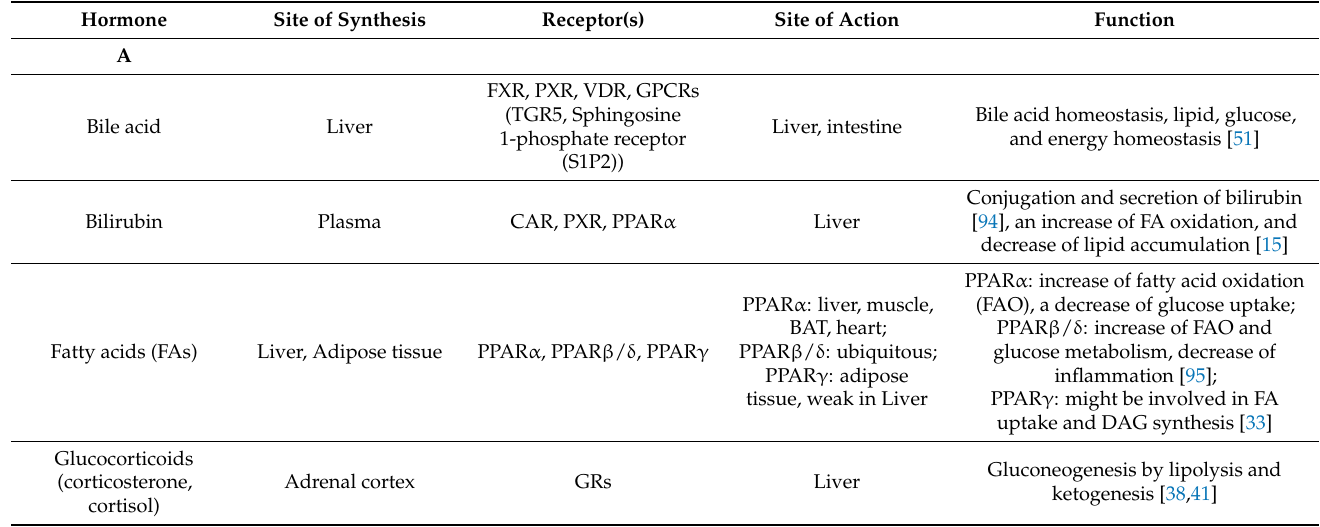
Table 1. Liver-specific signaling molecules. Hormones and metabolites acting via NRs (A) and NR-independent hormones (B) are